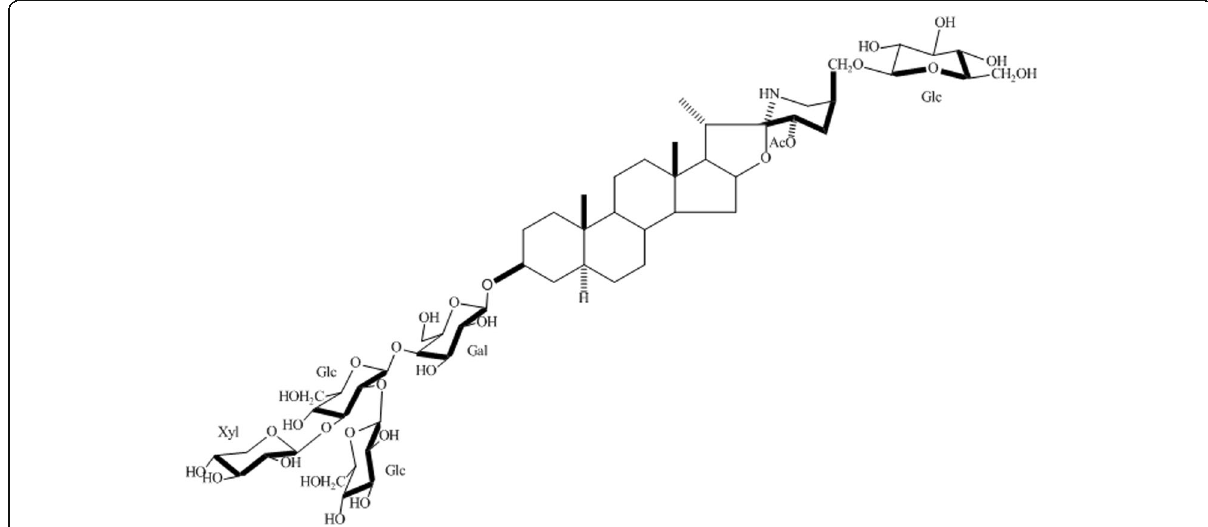
Fig. 1 Chemical structure of Esculeoside